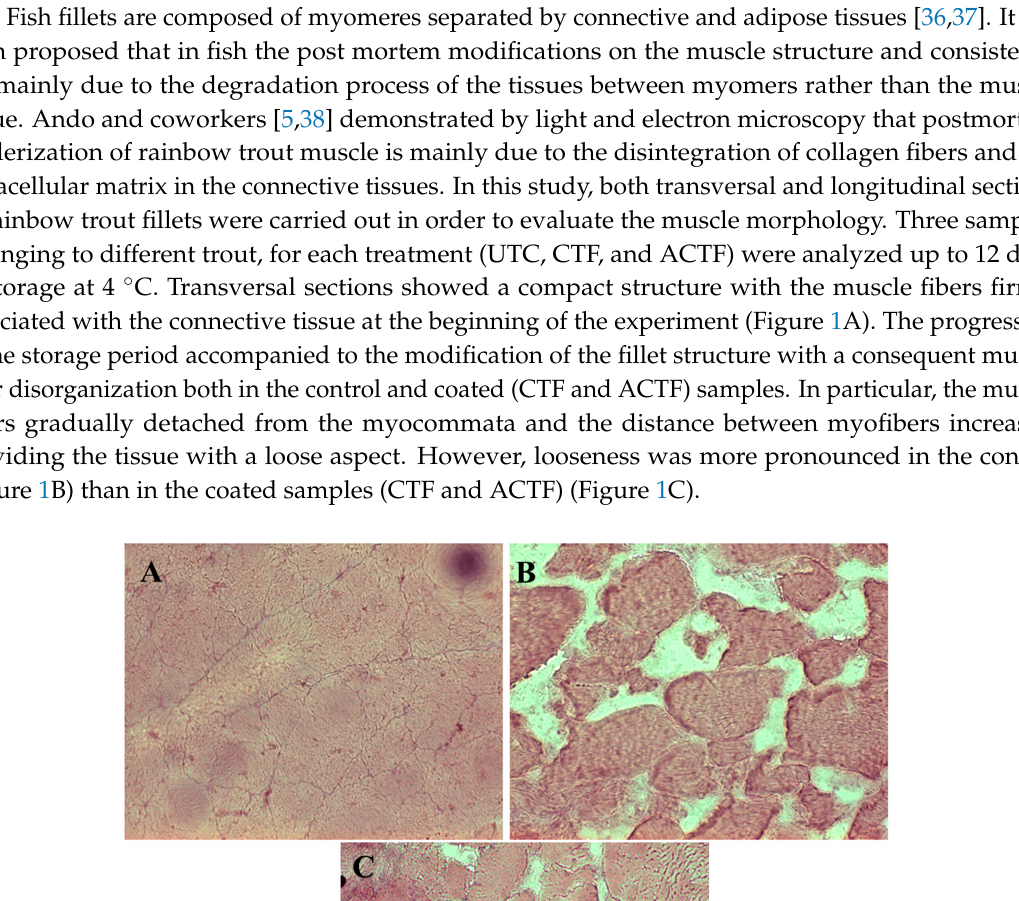
Figure 2. Hematoxylin–eosin staining of longitudinal sections of trout fillets. ( A ) uncoated fillet (UTF) after 12 day period of storage and ( B ) carrageenan coated fillet (CTF) after 12 days of storage; CTF and ACTF gave similar results. Scale bars: A,B: 10 μ m. Sections are representative of three trout analyzed for each experimental group.